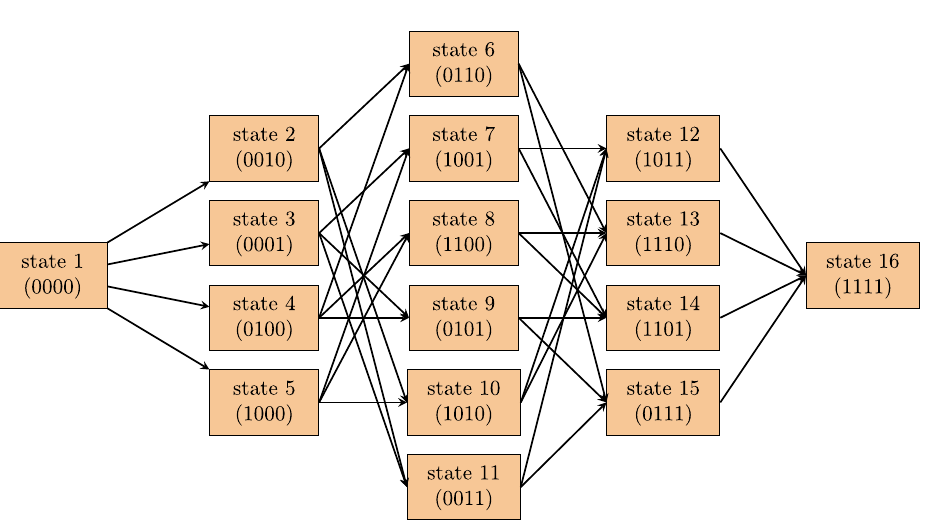
Figure 4. Network of states and transitions between them. Dissemination rates between states are represented by the six parameters tubo (tumor to bone), tulu (tumor to lung), tuli (tumor to liver), tubr (tumor to brain), luli (lung to liver), lubr (lung to brain), as follows: 1 → 2 tuli , 1 → 3 tubr , 1 → 4 tulu , 1 → 5 tubo , 2 → 6 tulu , 2